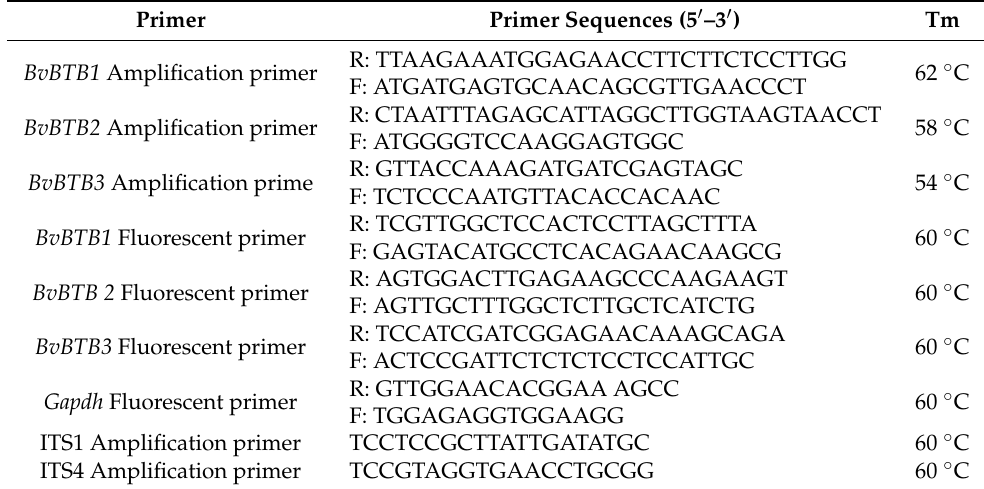
Table 1. Primers for cloning and expression of BvBTB1 , BvBTB2 , and BvBTB3 and ITS